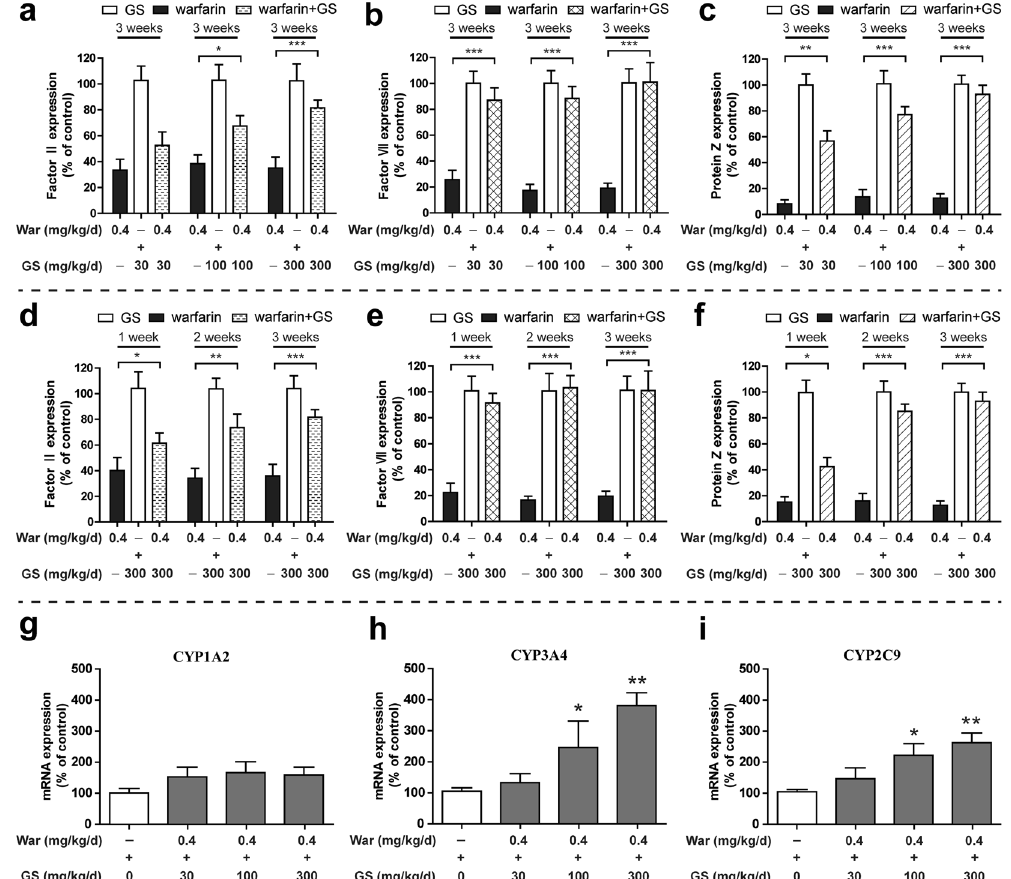
Figure 6. GS antagonized inhibition by warfarin of coagulation factors II, VII and protein Z, and enhanced activity of cytochrome P450 3A4 and 2C9 following one-week warfarin plus three-week warfarin co- administered with GS. ( a – c ) GS dose-dependent (30, 100 and 300 mg/kg/day for 3 weeks; ( a – c ), and time- dependent (300 mg/kg/day for 1, 2 and 3 weeks; ( d , e ) antagonism on inhibition by warfarin of coagulation factors II, VII and protein Z; ( g – i ) dose-dependent upregulation by GS (30, 100 and 300 mg/kg/day) on mRNA expression of rat hepatic cytochrome P450 CYP1A2, 3A4 and 2C9. All rats were pretreated with oral warfarin for 1 week followed by the co-administration regimen. Data represent the mean ± SD (n = 10 per group); * P < 0.05; ** P < 0.01; *** P < 0.001, compared with warfarin alone ( a – f ), or the untreated controls ( g – i